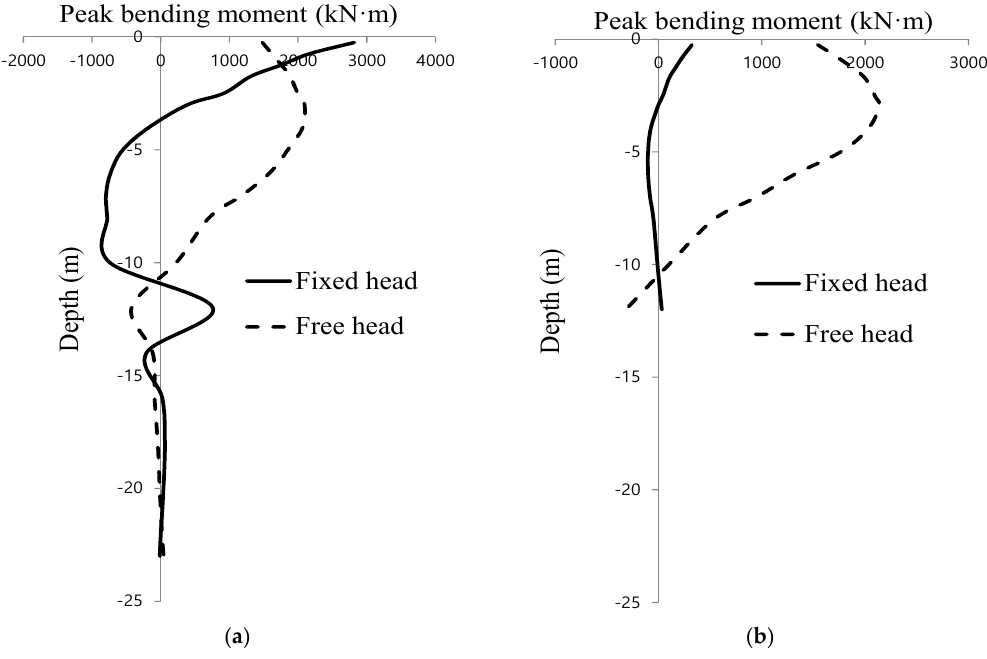
Figure 21. Peak bending moment profiles for different pile head fixity (input acceleration: 0.13g). ( a ) Pile length: 23 m (12.6 T); ( b ) Pile length: 8 m (4.4 T).